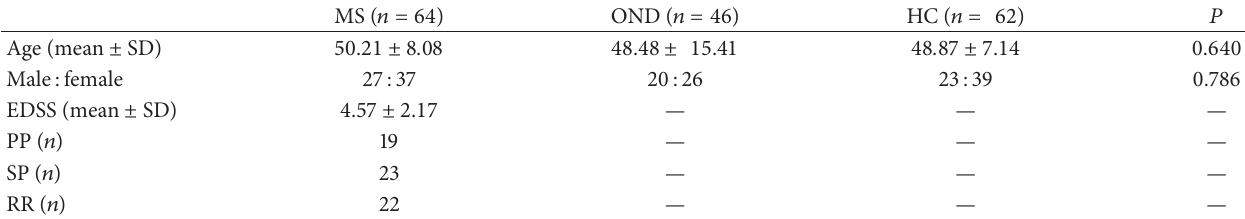
Table 1: Demographic and clinical characteristics of the MS, OND patients, OND and